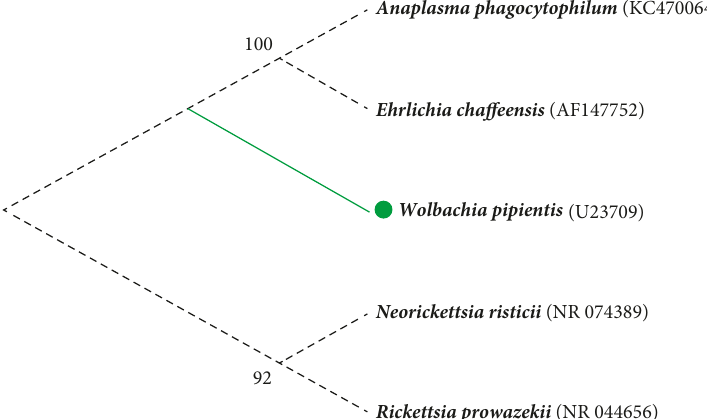
Figure 2: Molecular Phylogenetic analysis of Anaplasmataceae by Maximum Likelihood method. The evolutionary history was inferred using the Maximum Likelihood method based on the Tamura-Neimodel [30]. The tree with the highest log likelihood (-4338.5700)is shown. Thepercentageoftreesinwhichtheassociatedtaxaclusteredtogetherisshownnexttothebranches.Initialtree(s)fortheheuristicsearchwere obtained automatically by applying the Neighbor-Join and BioNJ algorithms to a matrix of pairwise distances estimated using the Maximum Composite Likelihood (MCL) approach, and then selecting the topology with the higher log likelihood value. The analysis involved five nucleotide sequences. All positions containing gaps and missing data were eliminated. There was a total of 1,411 positions in the final dataset. Evolutionary analyses were conducted in MEGA7